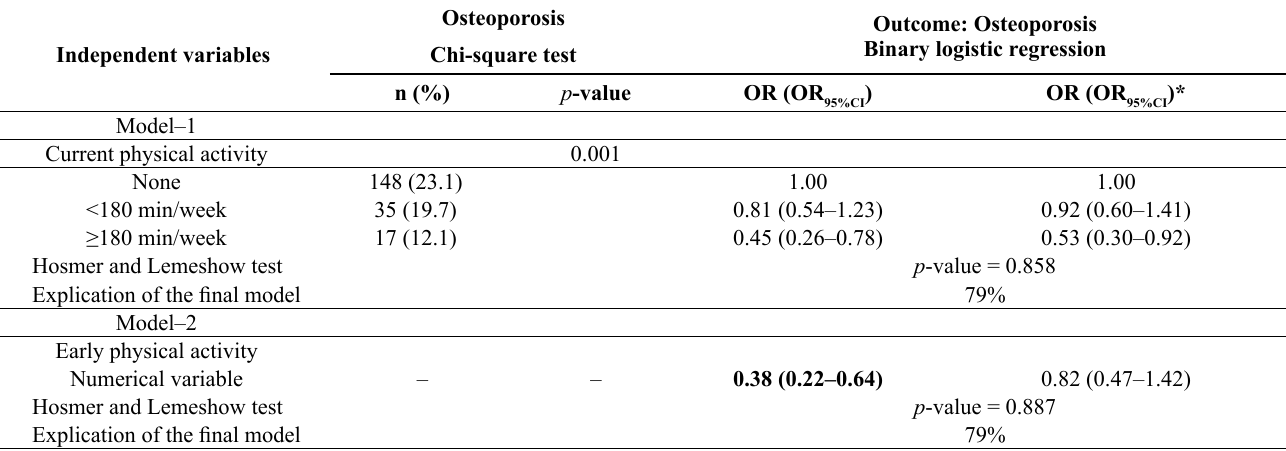
Table 2. Associations between osteoporosis and early/current physical activity among Brazilian adults (n = 963)